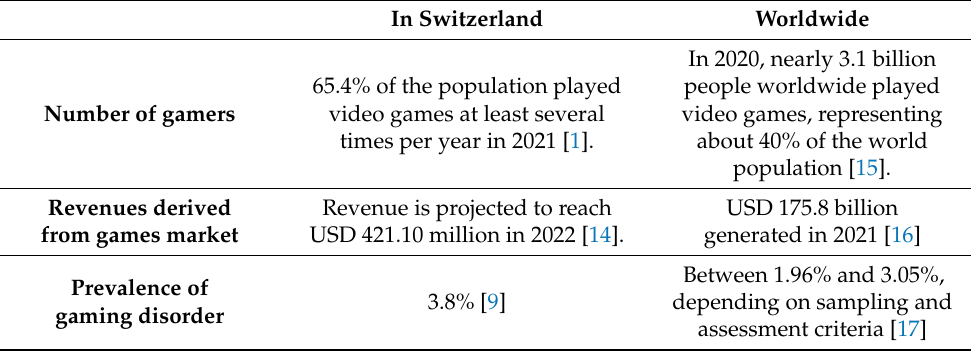
Table 1. Epidemiological